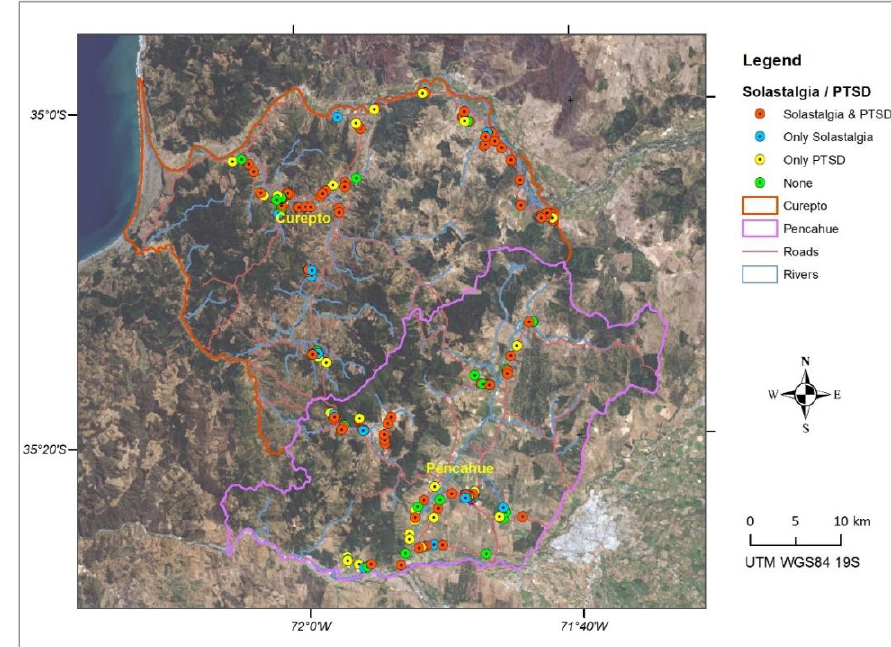
Figure 6. Spatial distribution of integrated solastalgia and PSDT cases.